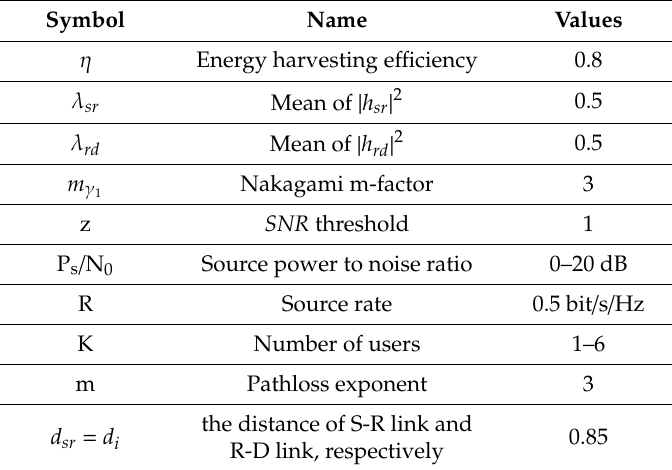
Table 1. Simulation